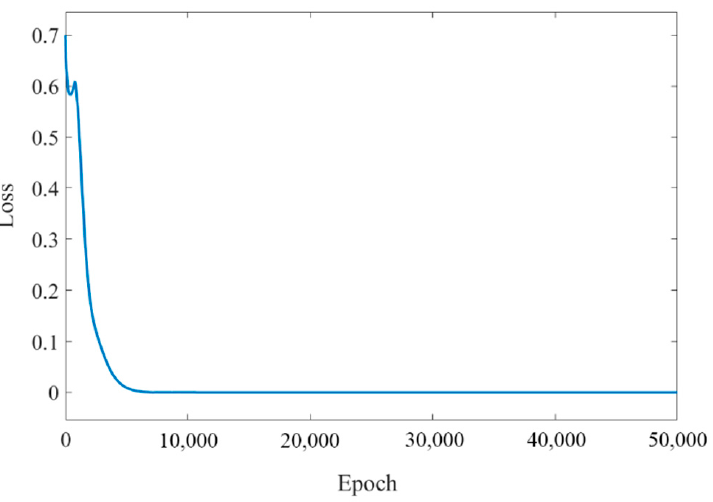
Figure 12. Training error curve of BP-PID-Smith controller under model matching.